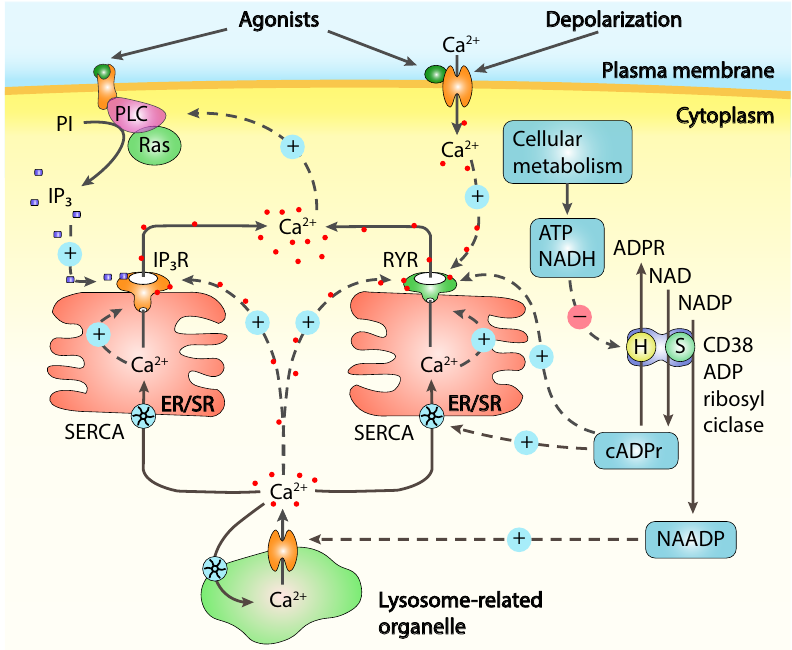
Figure 1. Schematic overview of the main Ca 2+ signalling mechanisms. Calcium release from the intracellular calcium stores is mainly mediated by inositol-1,4,5-triphosphate receptors (IP 3 Rs) and ryanodine receptors (RYRs), sensitive to signals present both inside and outside the endo- plasmic/sarcoplasmic reticulum (ER/SR). Inositol-1,4,5-triphosphate (IP 3 ) is produced by different isoforms of phospholipase C (PLC) and binding to IP 3 Rs can trigger calcium release. The CD38 ADP ribosyl cyclase has both synthase (S) and hydrolase (H) functions producing cyclic ADP ribose (cADPr) and nicotinic acid adenine dinucleotide phosphate (NAADP) and has been proposed to act as a cellular metabolism sensor since ATP and NADH can inhibit the hydrolase enzymatic function. The exact way cADPr and NAADP influence calcium release is still unclear but they seem to indi- rectly act on both RYRs and IP 3 Rs. cADPr might enhance sarco(endo)plasmic reticulum Ca 2+